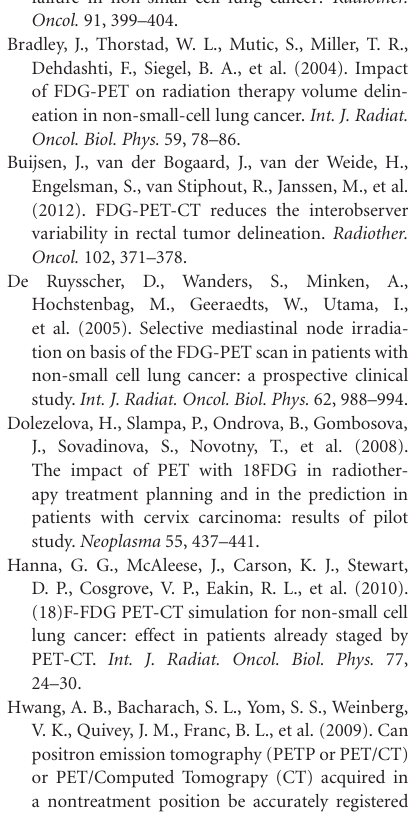
ASSESSMENT OF PRE-TREATMENT